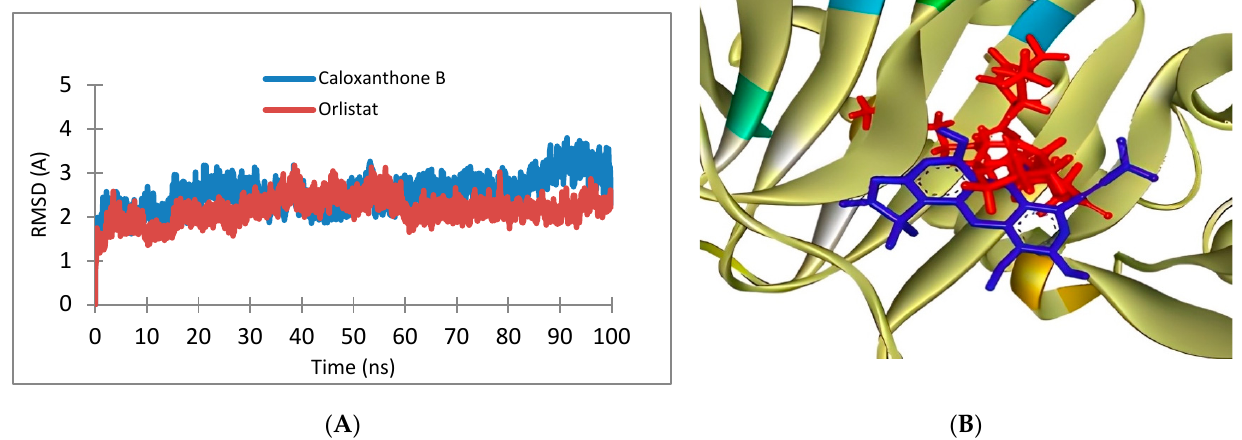
Figure 10. ( A ) Graphic of Root Mean Square Deviation (RMSD) of caloxanthone B and orlistat; ( B ) 3D interaction of caloxanthone B (Blue) and orlistat (Red) to fat mass and obesity-associated protein (FTO). Table 7. Interaction energy of orlistat and caloxanthone B to fat mass and obesity-associated protein (FTO).